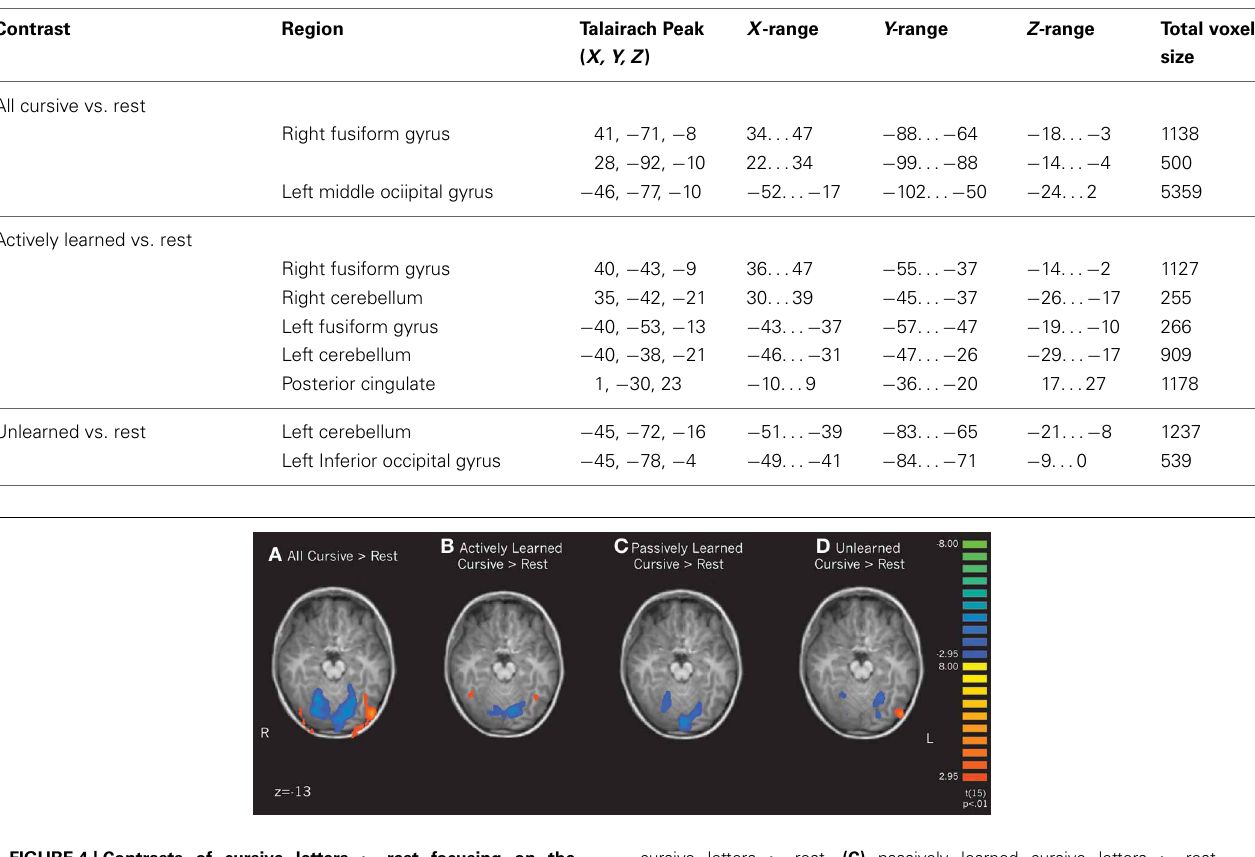
FIGURE 4 | Contrasts of cursive letters > rest focusing on the lateral occipital complex and the fusiform gyrus. Depicts individual contrasts of (A) all cursive letters > rest, (B) actively